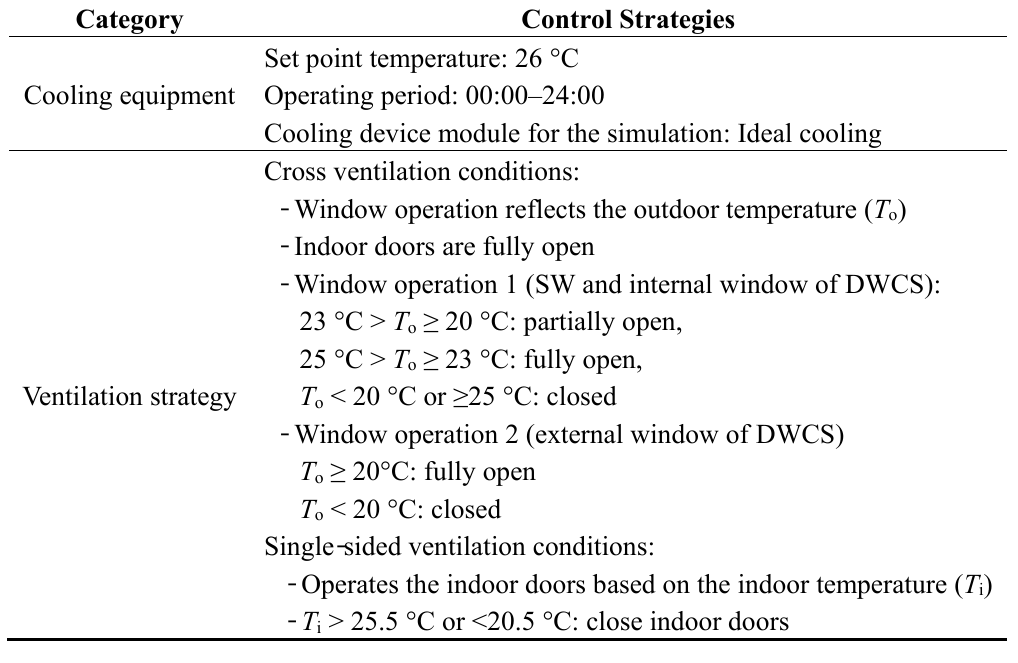
Table 5. Window control strategies during the cooling season.